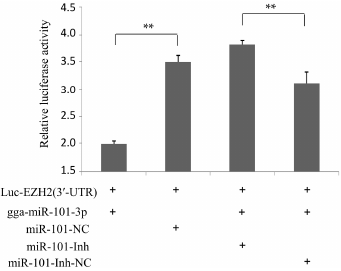
Figure 2. EZH2 is the direct target of gga-miR-101-3p. DF-1 cells were co-transfected with Luc-EZH2 (3 ′ -UTR) and the indicated RNA oligonucleotides. At 24 h of post-transfection, the cells were assayed for both firefly and renilla luciferase using the dual-luciferase glow assay. Three independent experiments were performed and each sample was tested in triplicates. Data are expressed as means ± SD. Two-tailed Student’s t -test was used to analyze the significant differences (** p < 0.01).